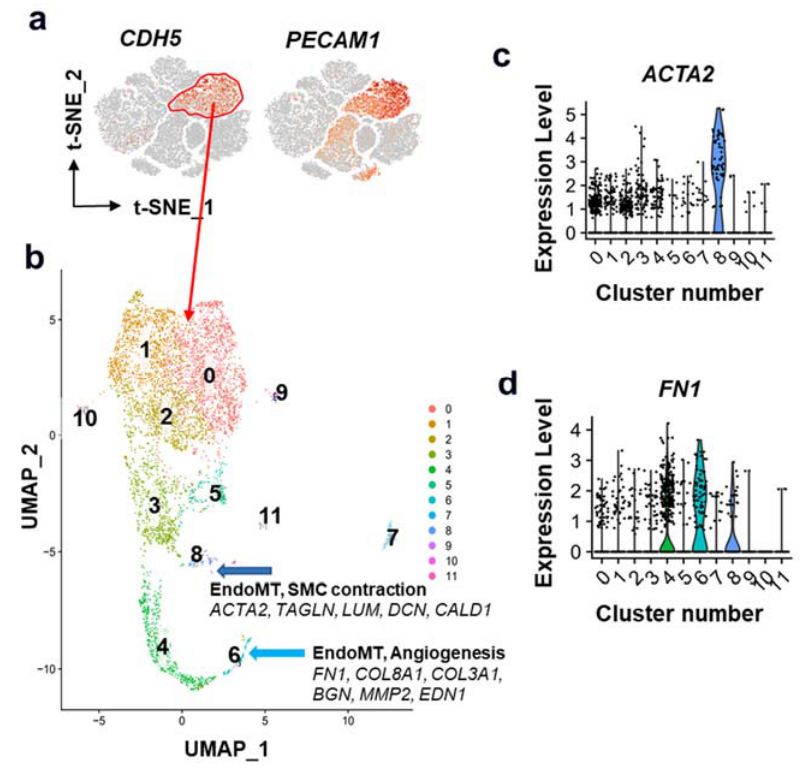
Figure 2. EndoMT in human coronary artery atherosclerosis. Publicly available scRNAseq data from Wirka et al. [30] on unsorted cells from atherosclerotic human coronary arteries were reana ‐ lyzed. ( a ) EC cluster was determined based on the expression of CDH5 and PECAM1 (red oval). ( b ) Cells from the EC cluster were further analyzed using higher cluster resolution. We observed two clusters, 6 and 8, enriched with EndoMT markers. ( c ) Interestingly, only cluster 8 had ACTA2 + and other SMC contractile marker ‐ positive cells. ( d ) Cluster 6 was enriched with FN1 , collagens, and pro ‐ angiogenesis genes.